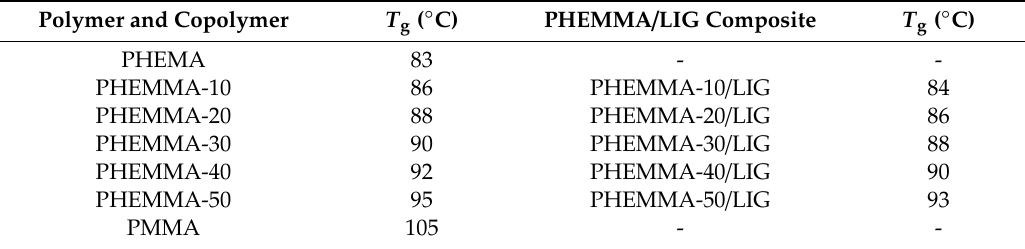
Figure2. DSCthermogramsofpurePHEMA,PMMA,andPHEMMAwithdi ff erentmethylmethacrylate (MMA) contents. Comparison between the T g values of the PHEMMA copolymers and those of the PHEMMA / LIG